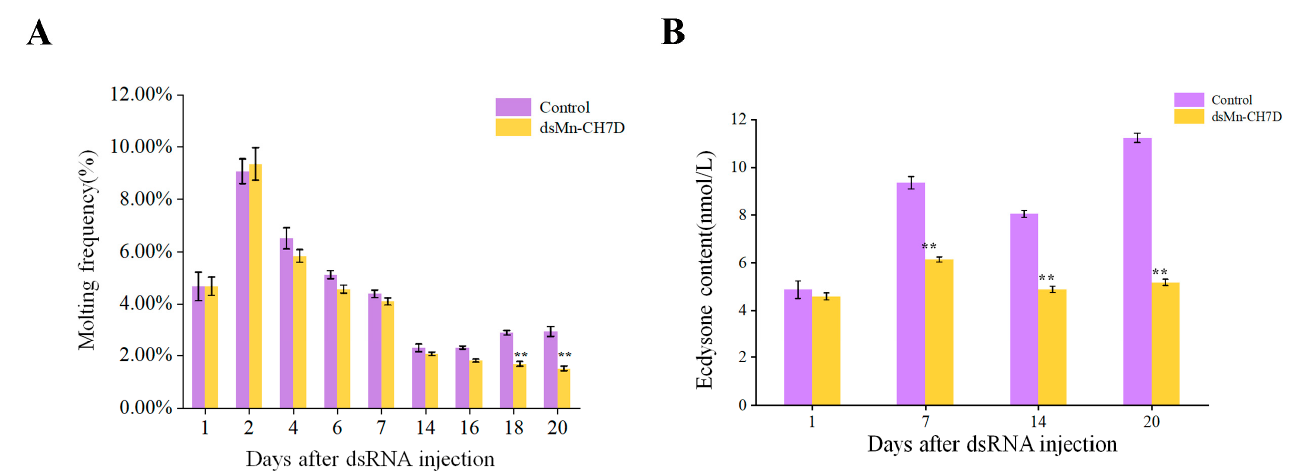
Figure 8. The molting frequency ( A ) and ecdysone content ( B ) of Macrobrachium nipponense after injection with Mn-CH7D dsRNA. Data are shown as mean ± SD (n = 6). “**” indicates the significance of the differences ( p <